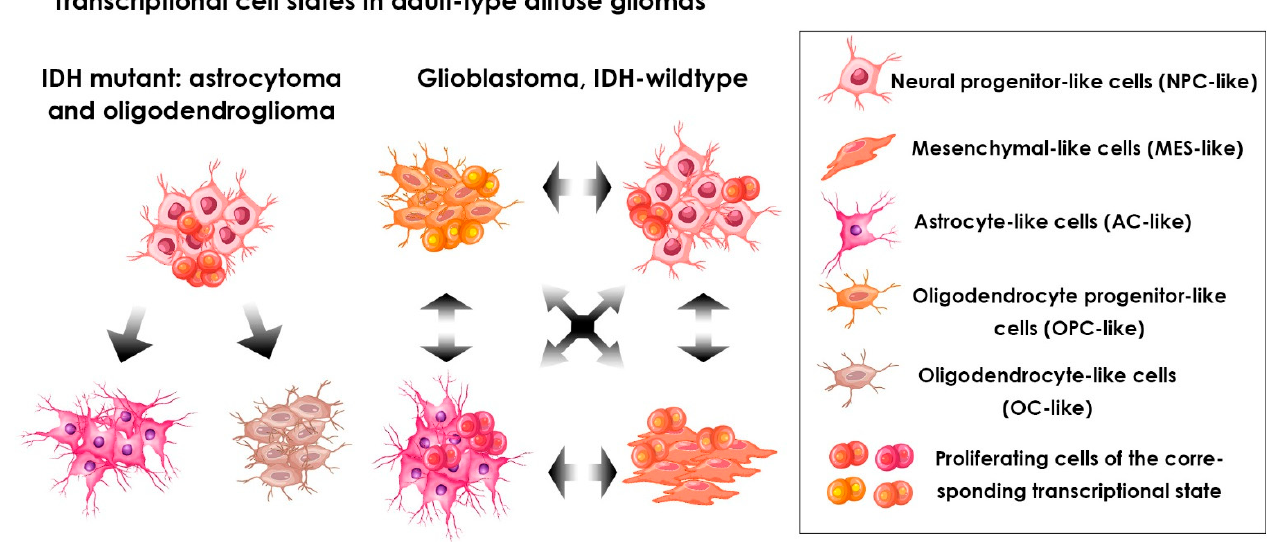
Figure 2. Transcriptional cell states in adult-type diffuse gliomas revealed by the single-cell RNA sequencing performed by Venteicher et al. [141] and Neftel et al. [142]. The cell states were defined based on the stemness/differentiation and proliferation signatures. Arrows represent revealed transitions between transcriptional cell states.